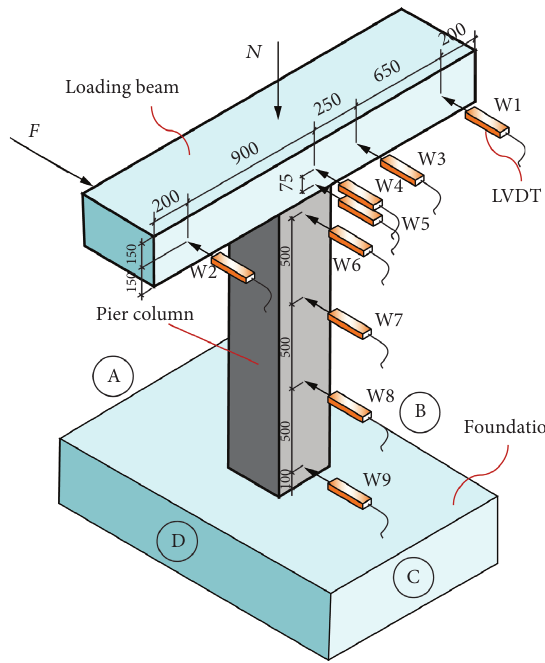
Figure 5: Arrangement of LVDTs.